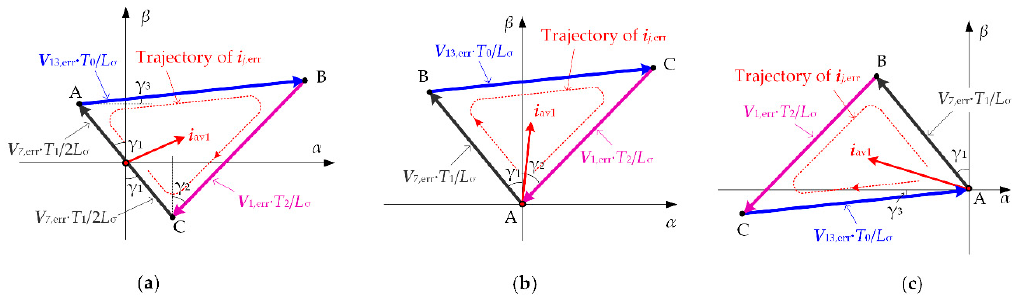
Figure A1. Trajectory of current ripple vector i j,err for Sequence 31–33 in Triangle 3 (cid:79) of Sector Z 1 : Figure a1. Trajectory of current ripple vector i j,err for Sequence 31–33 in Triangle ③ of Sector Z 1 : ( a ) ( a ) Sequence 31; ( b ) Sequence 32; ( c ) Sequence Sequence 31; ( b ) Sequence 32; ( c ) Sequence 33.